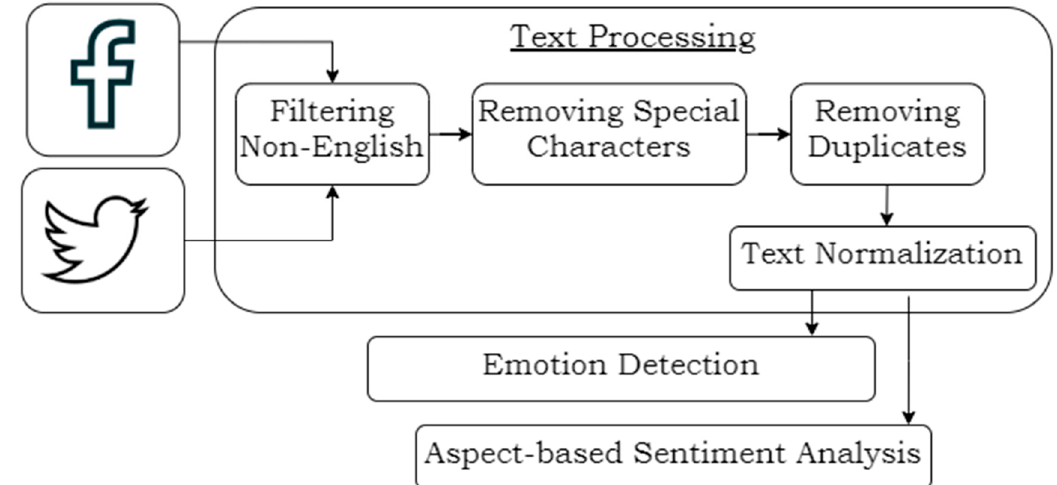
Figure 1. Overview of the methodology.